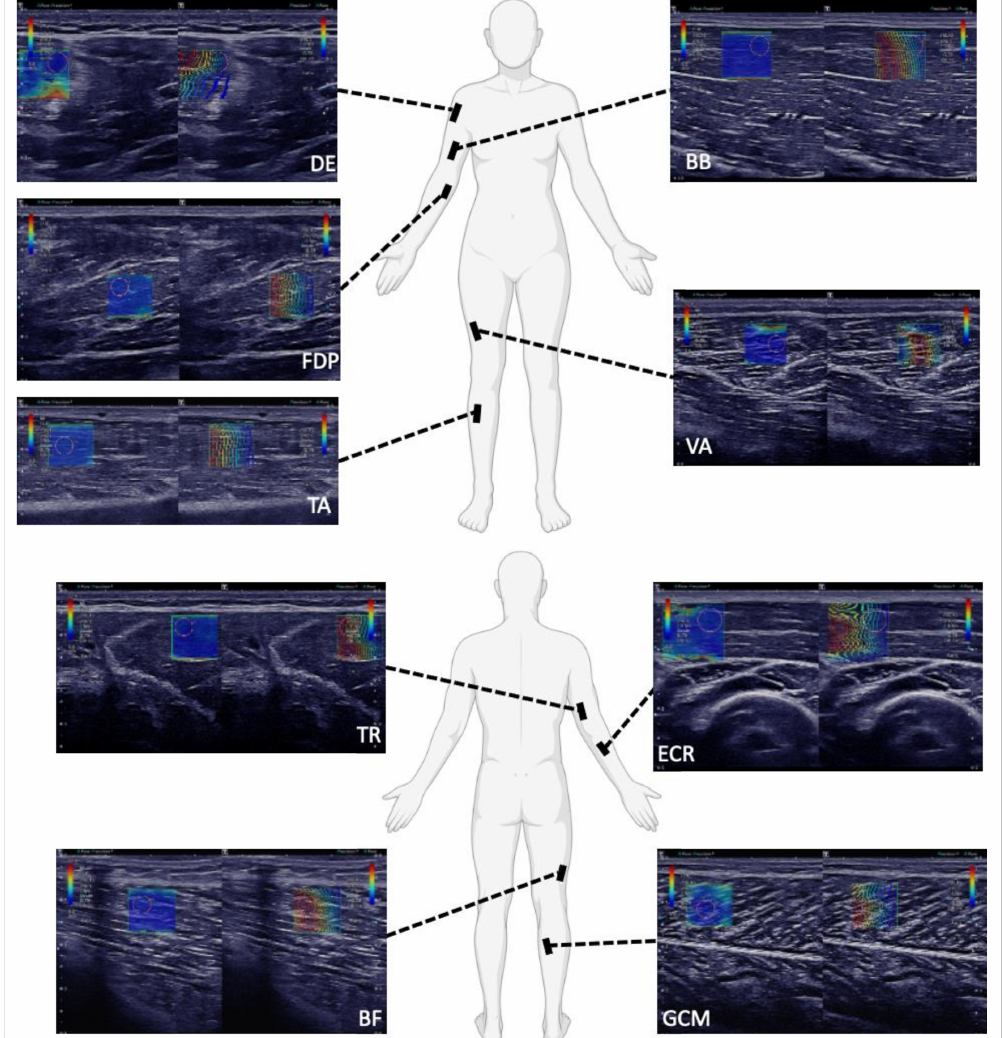
Figure A1. SWE images of the examination of a 32-year-old male in Protocol 2 (optimized, rigid SWE-protocol): SWE pictures of the deltoid (DE), flexor digitorum profundus (FDP), tibialis anterior (TA), biceps brachii (BB) and vastus lateralis (VA) muscle, triceps brachii (TR), biceps femoris caput longum (BF), extensor carpi radialis (ECR) and gastrocnemius caput mediale (GCM) muscle are shown. On the left side of each picture, the B-mode images in gray scale are overlaid with SWV data in color. The cooler colors, such as the blue in these pictures, depict slower shear wave speeds, typically ranging from 0–6 m/s. As predicted, in Protocol 2 (optimized, rigid SWE-protocol), the muscles were positioned in optimally relaxed states, to avoid strain, which was demonstrated by the consistent blue coloring within the SWE pictures. On the right side of each picture, the shape of the shear waves is displayed with lines. The blue lines represent the origin of the shear waves and the red lines represent the change in the shear waves as they propagate accordingly through the muscle. In these pictures, the greater depth of acquisition required for FDP and DE can be seen. The layer of subcutaneous fat above the DE was typically thicker than for TA, BB and VA. Additionally, the greater pennation angle of DE is illustrated in that the muscle fibers could not be completely optimally displayed to parallel in the longitudinal plane. Alternatively, the path of the muscle fibers of FDP, TA, BB and VA could be displayed well in the longitudinal